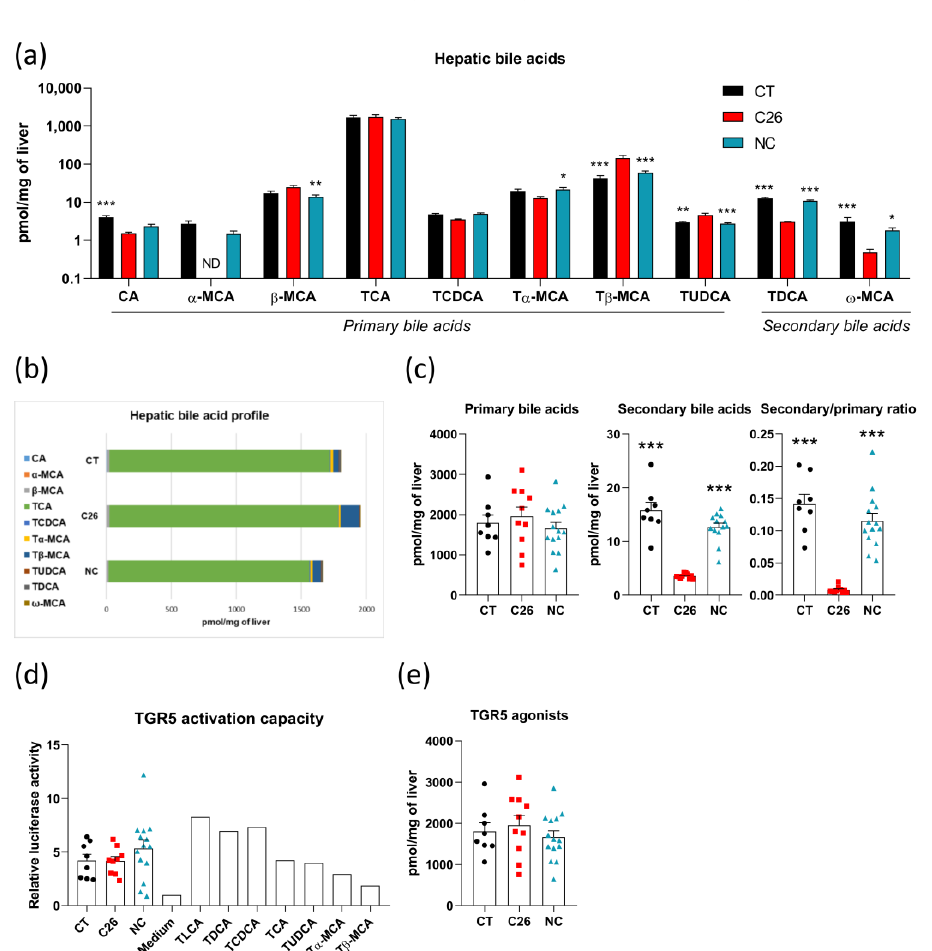
Figure 3. Alterations in bile acid profile are intrinsically related to cachexia without any modifica- tion of TGR5 activation capacity in C26 mice. ( a ) Hepatic bile acids in sham-injected mice (CT; n = 8), mice injected with cachexia-inducing C26 colon carcinoma cells (C26 mice; n = 10), and mice injected with non-cachexia-inducing C26 colon carcinoma cells (NC mice; n = 14). ( b ) Hepatic bile acid profile in CT, C26, and NC mice. ( c ) Primary and secondary bile acid levels and Secondary/primary ratio in the liver of CT, C26, and NC mice. ( d ) TGR5 activation capacity using cell reporter assay incubated with portal plasma of CT, C26, and NC mice or 10 µ M of bile acids. ( e ) TGR5 agonists (including CA, TCA, TCDCA, TUDCA, and TDCA) levels in the liver of CT, C26, and NC mice. ND, Not detected; CA, cholic acid; α-MCA, α-muricholic acid; β-MCA, β-muricholic acid; TCA, tauro-cholic acid; TCDCA, tauro-chenodeoxycholic acid; Tα-MCA, tauro-α-muricholic acid; Tβ- MCA, tauro-β-muricholic acid; TUDCA, tauro-ursodeoxycholic acid; TDCA, tauro-deoxycholic acid; ω-MCA, ω-muricholic acid. CDCA, DCA, lithocholic acid (LCA), and TLCA were undetected. Data are presented as mean ± SEM, * p < 0.05, ** p < 0.01, *** p < 0.001 vs. C26.